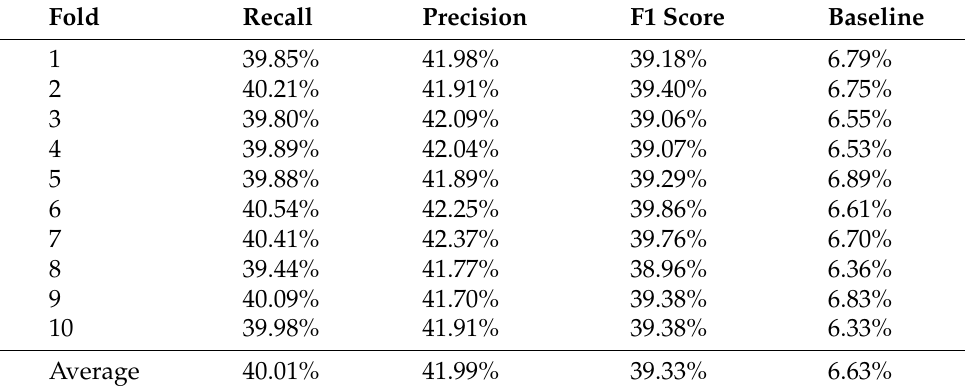
Table 6. The performance of 10-fold cross validation.